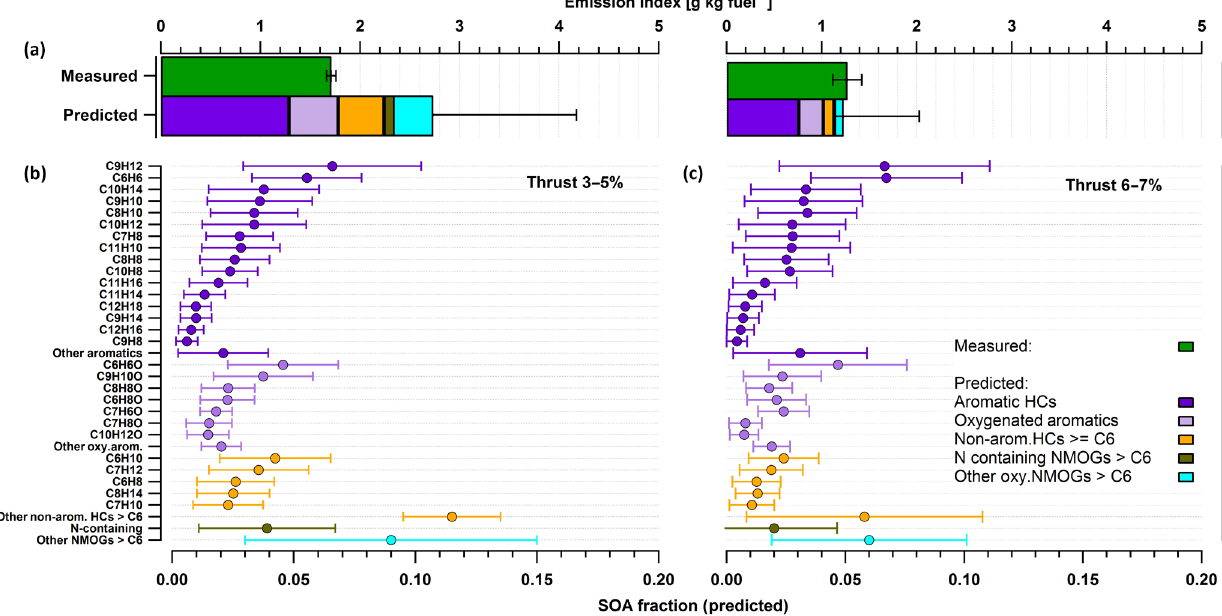
Figure 5. Comparison of the SOA measured by the AMS and the SOA predicted by the oxidation of NMOGs (a) . The statistics are presented for low load idling (thrust 3–5%) on the left and for idling 6–7% on the right. Aromatic hydrocarbons (purple) were the most abundant precursors of SOA at idle (thrust 3–7%) explaining all SOA formed (green, a ) at thrust 3–5% and most ( ∼ 90%) at thrust 6–7%. Aromatic SOA comprised the largest fraction followed by oxygenated aromatics (light purple – e.g., phenol, benzaldehydes), nonaromatic hydrocar- bons (orange) with more than 6 carbon atoms in their molecular structure (nonarom. HCs ≥ C6), nitrogen-containing compounds (brown), other oxygenated-NMOGs > C6 (cyan). Average fractions of individual NMOGs (b, c) were calculated by using SOA yields from literature (see Table 2) and the amount of NMOG reacted. Error bars show standard deviations of the means (CI: